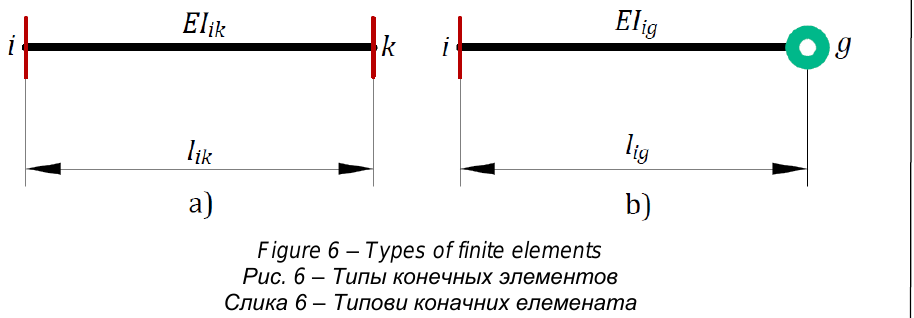
Figure 6 – Types of finite